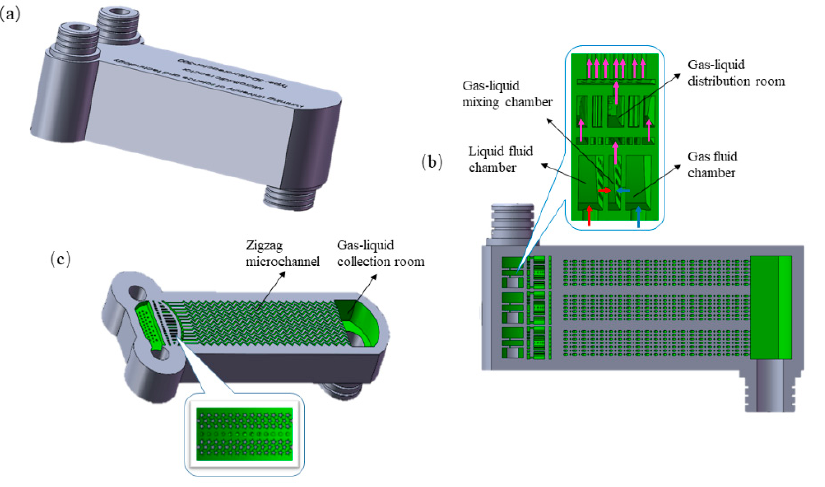
Figure 1. Structural design diagram of 3D-printed multichannel large-volume microchannel reactor: ( a ) reactor diagram; ( b , c ) reactor ( a ) reactor diagram; ( b , c ) reactor profiles.